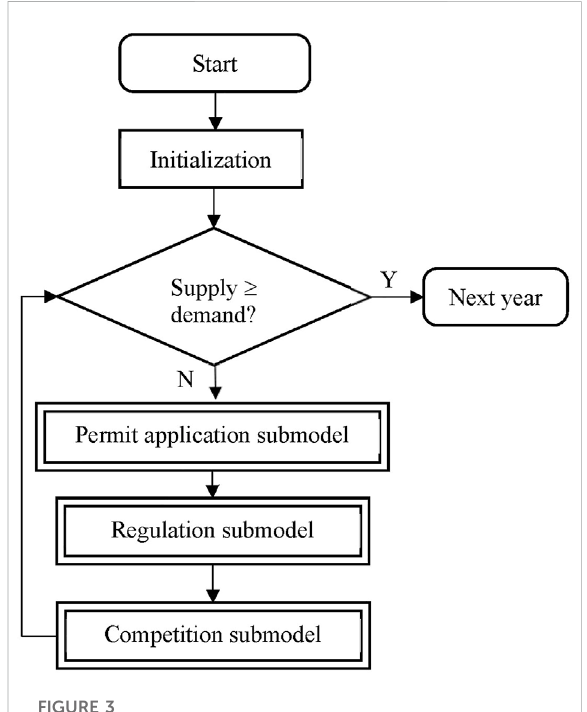
FIGURE 3 Process overview and scheduling of the agent-based